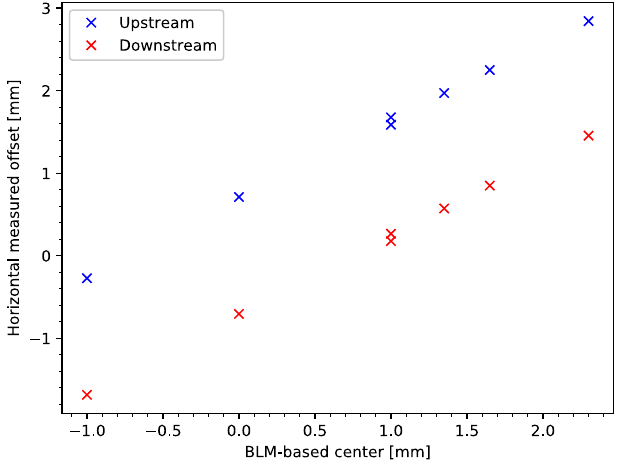
FIG. 10. The horizontal beam offset measured by the BPMs as a function of the beam center measured by the BLM-based technique for different shifts of the local closed